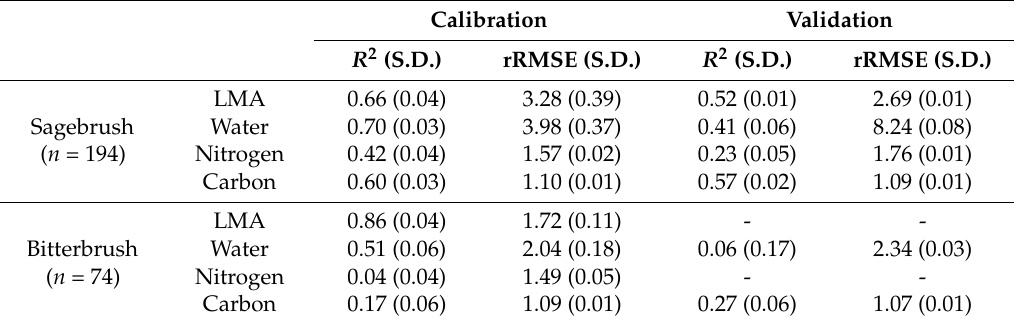
Table 3. Results of PLSR canopy-level biochemical traits in sagebrush and bitterbrush.